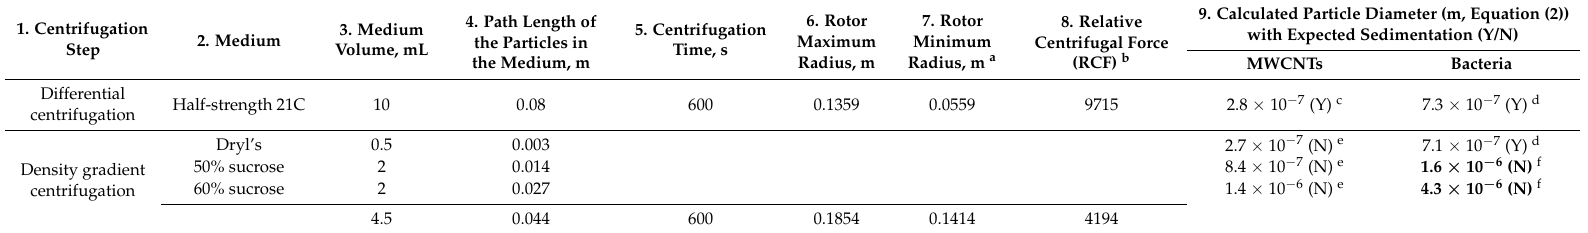
Table 2. Parameters employed in separating bacteria from MWCNTs and estimated minimum diameters of MWCNTs and bacteria that would pellet (Column 9) at the relative centrifugal forces and centrifugation time used in the experiments.